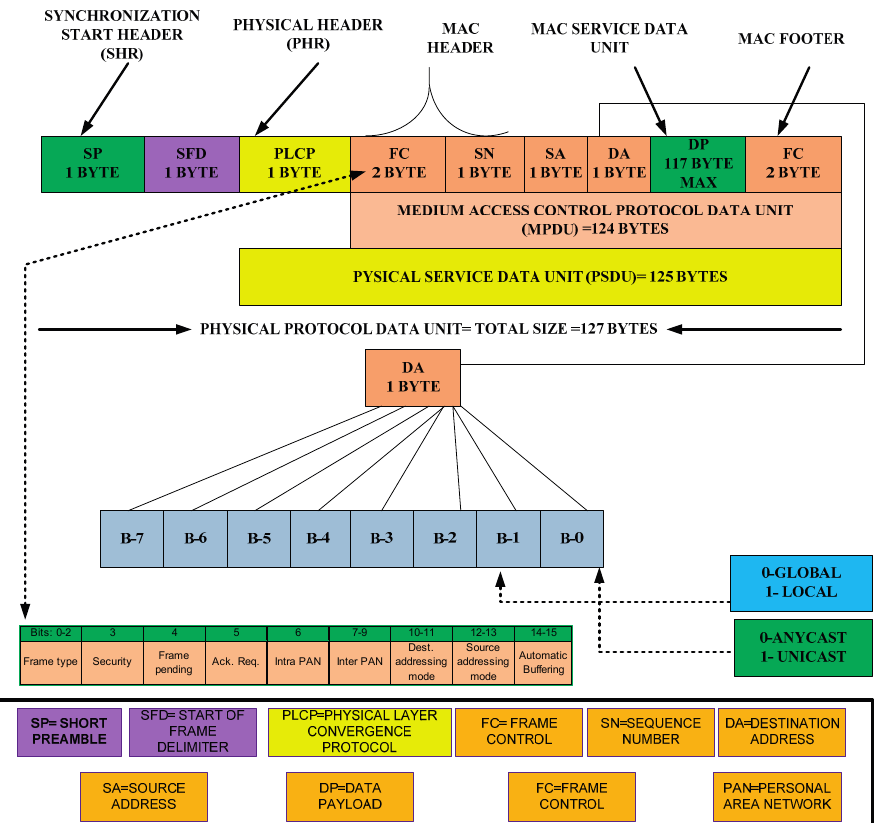
Figure 2. Optimized data frame